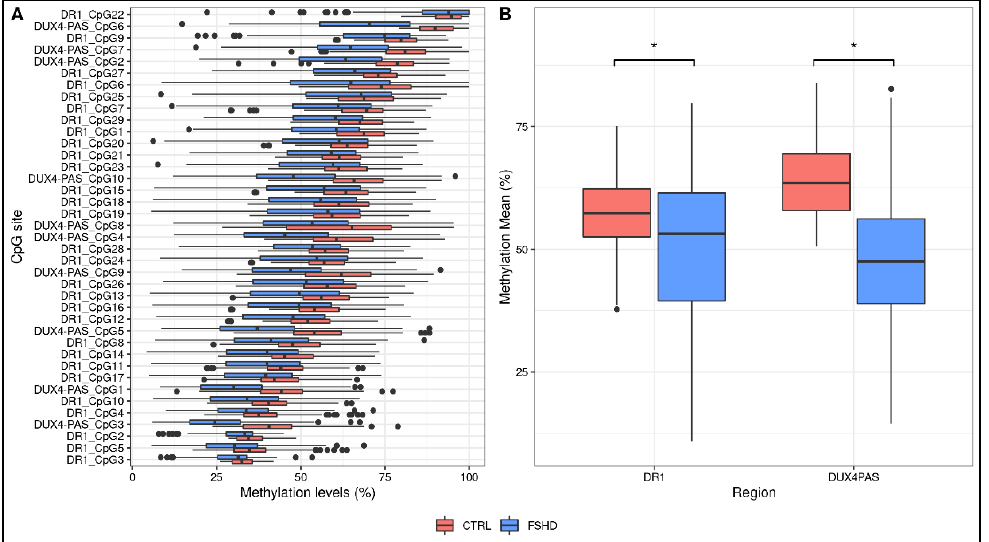
Figure 2. Descriptive plots of the analyses performed on the study cohorts. ( A ) A boxplot showing the methylation levels of each CpG site within DR1 and DUX4 -PAS regions related to the training group (FSHD n = 133, CTRL n = 150). The lower and upper hinges correspond to the 25th and 75th percentiles of the distribution. The whiskers extend from the hinge to the largest value no further than ±1.5 × IQR upper whisker extends from the hinge to the largest value no further than 1.5 × IQR from the hinge (where IQR is the inter-quartile range, or distance between the first and third quartiles). The lower whisker extends from the hinge to the smallest value at most 1.5 × IQR of the hinge. Data beyond the end of the whiskers are called “outlying” points and are plotted individually. ( B ) The average methylation levels are different between groups for both DR1 and DUX4 -PAS regions. * p < 0.05.